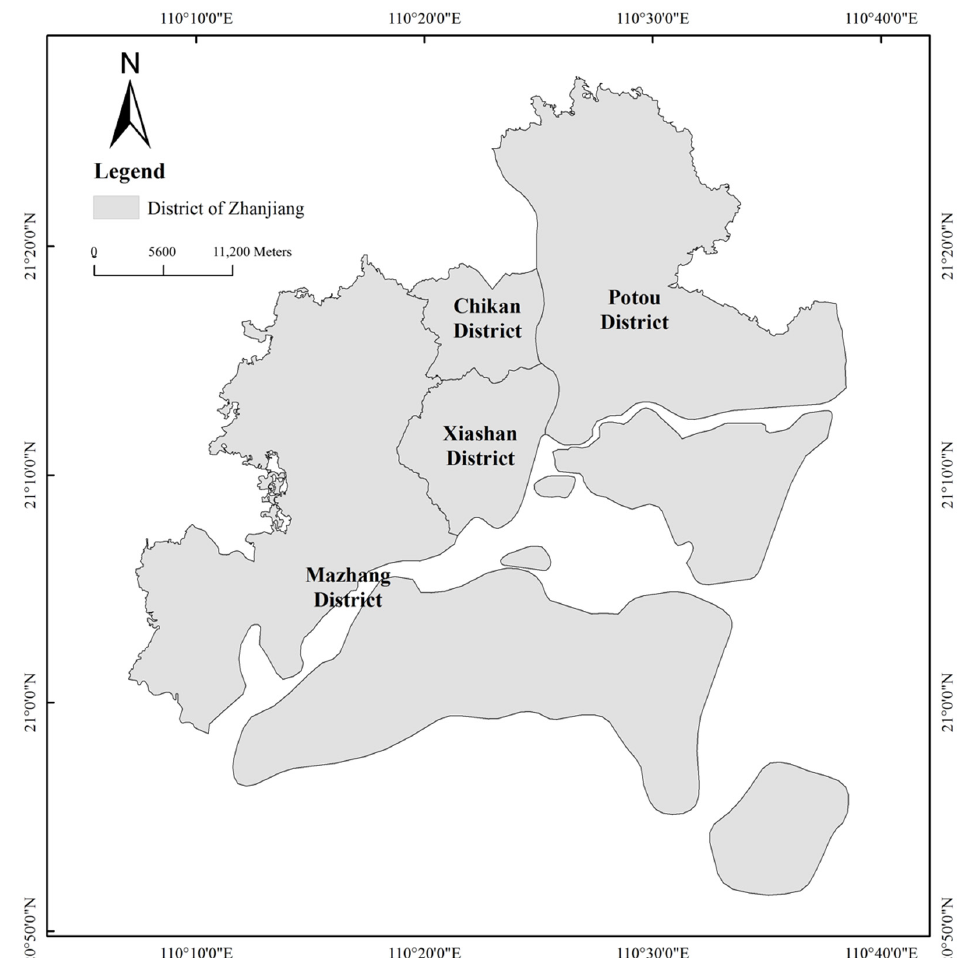
Figure 1. The map of four districts of the study area .